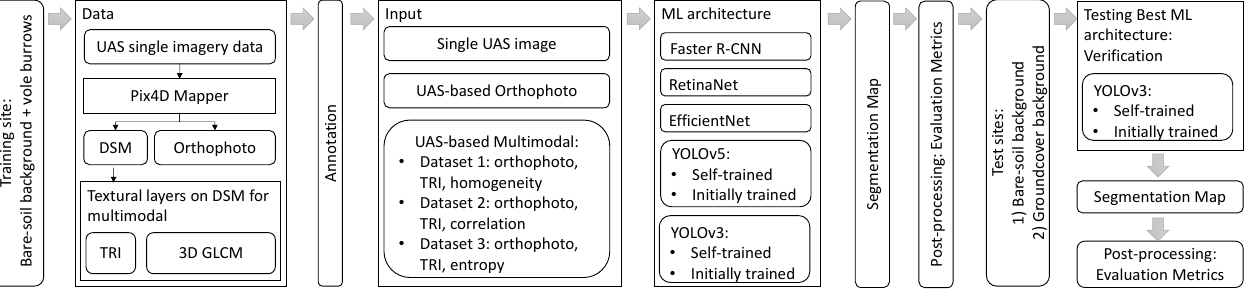
Figure 1. Overall flowchart.